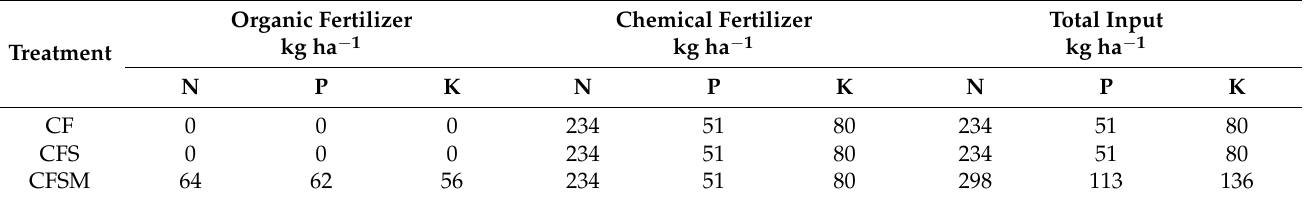
Table 2. Annual N, P, and K inputs in mollisol with different fertilization treatments from 2015 to 2021.